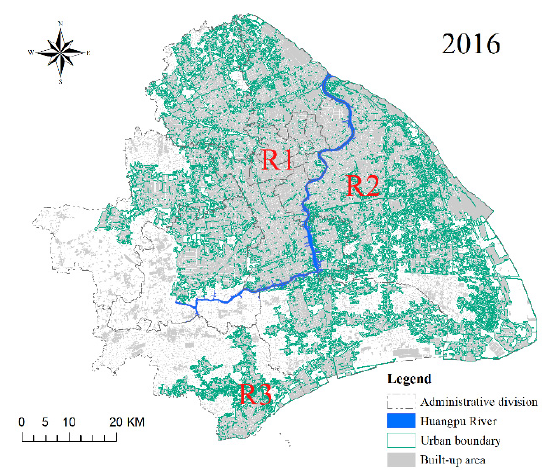
Figure 10. Identified urban boundaries where the R1–3 mean the 1st, 2nd and 3rd rank cluster, respectively.